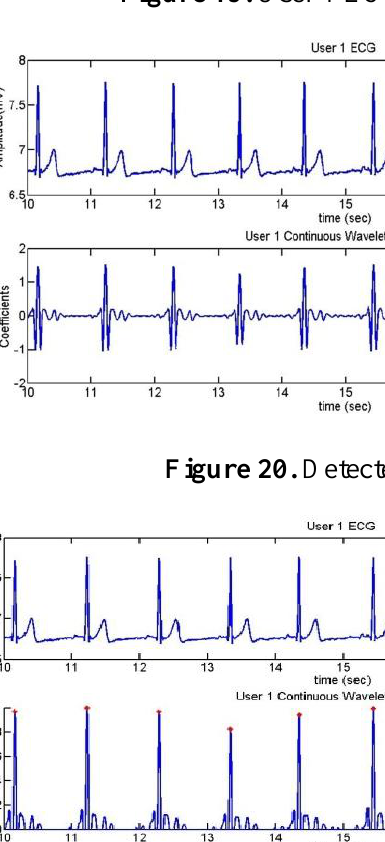
Figure 19. User 1 ECG and CWT.